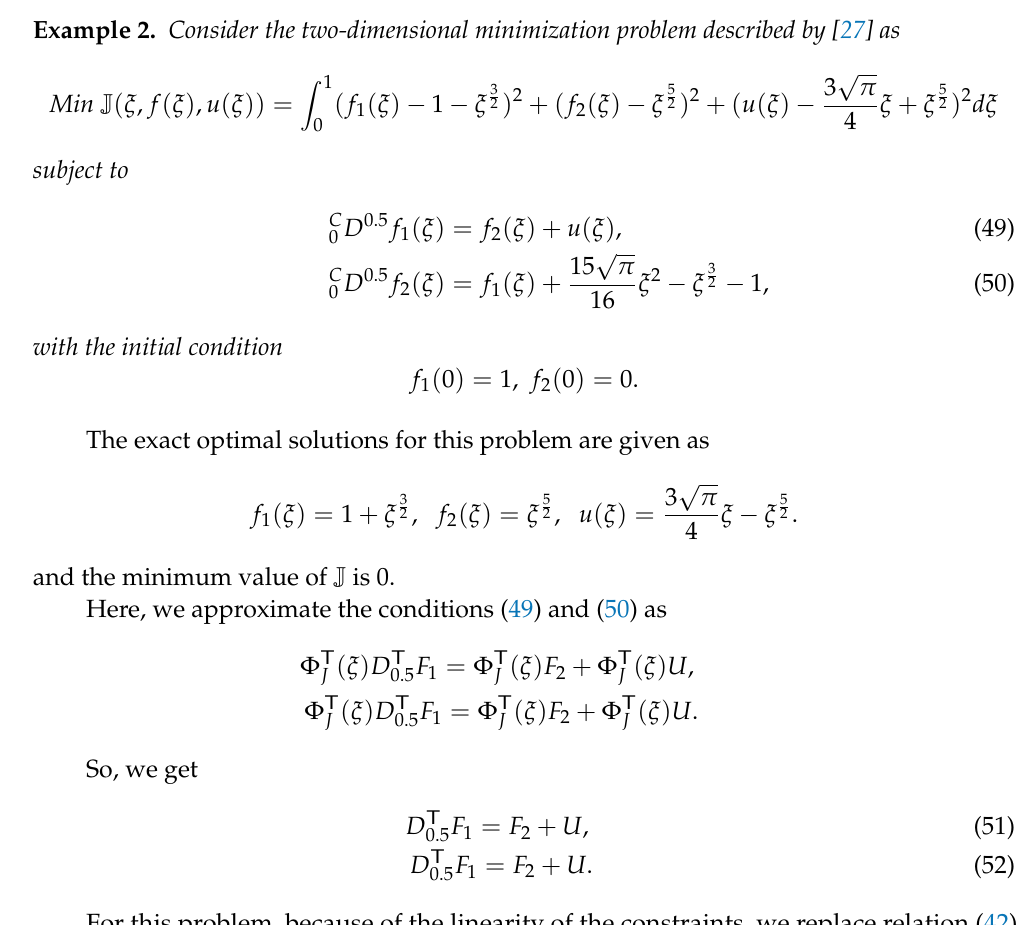
Figure 1. Plots of the state and control variables obtained for α = 0.8,0.9,.099,1 and the exact solution for α = 1 in Example